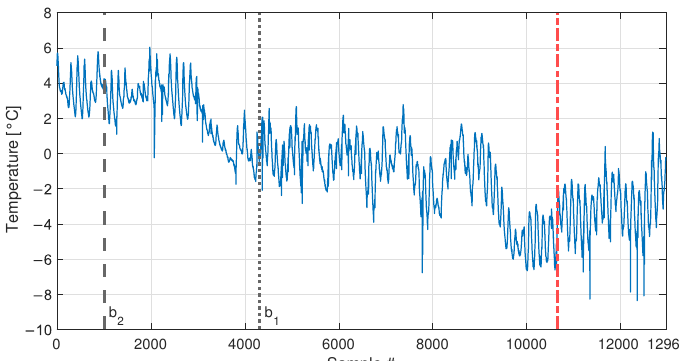
Figure 16. Real temperature trend, including daily trends and long-term drift. Black vertical dotted and dashed lines identify the number of samples used as baseline in sim 6 and sim 5, respectively. The beginning of the damage related data of sim 7 and 8 of Table 3 is indicated by a red vertical dot-dashed